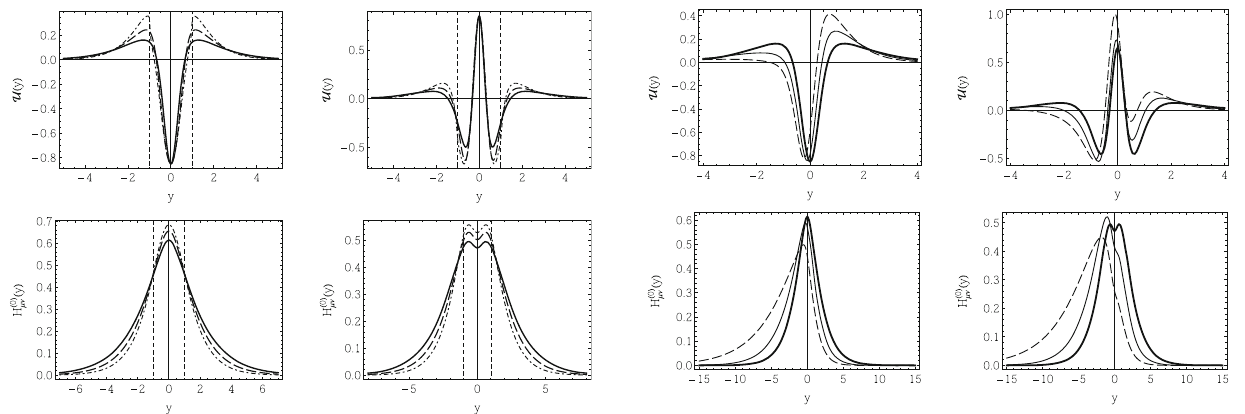
= − ϕ = − 10 (right panel) 0 0